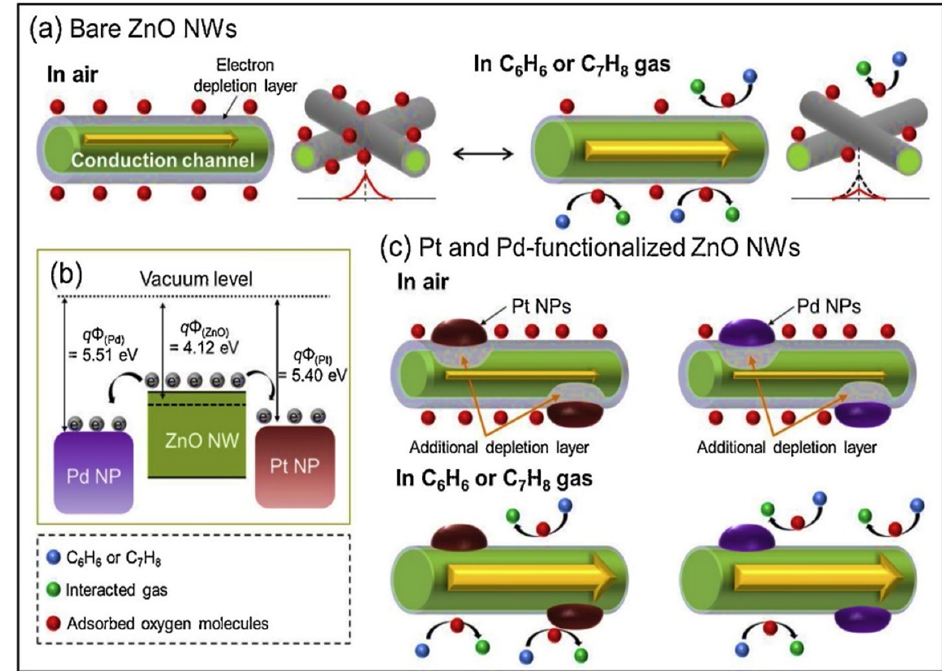
Figure 24. ( a ) Sensing mechanism of pristine ZnO NWs, ( b ) work functions of ZnO, Pd, and Pt/Pd- functionalized ZnO NWs, and ( c ) sensing mechanism of Pt- and Pd-functionalized ZnO NWs. Reproduced from [117] with the permission of Elsevier.